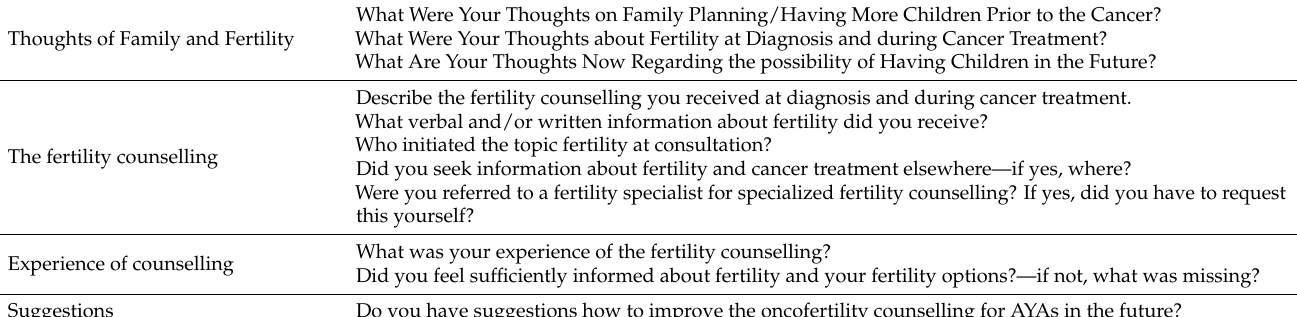
Table 1. Sample questions from the semi structured interview